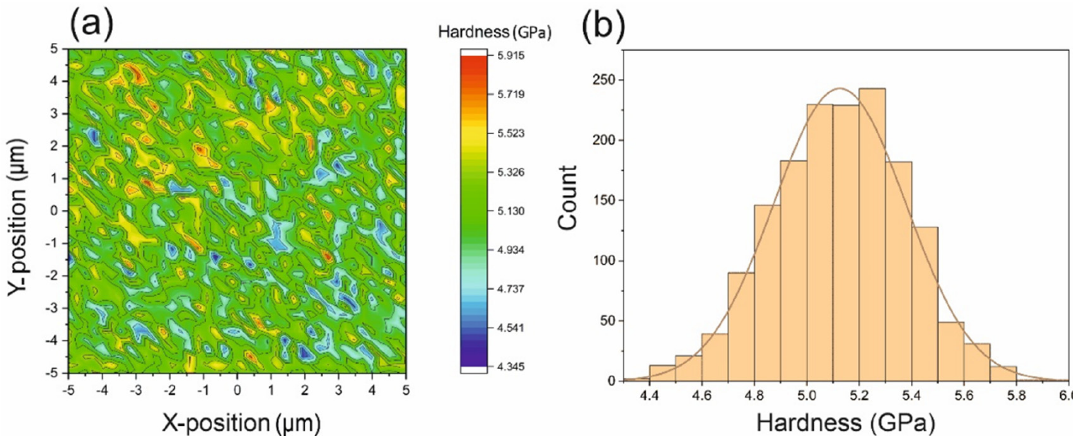
Figure 24. ( a ) Nanohardness map of 1600 indents, AMZ4 sample, and ( b ) histogram of the hardness results. Modified from [32], with permission from Elsevier, 2021.